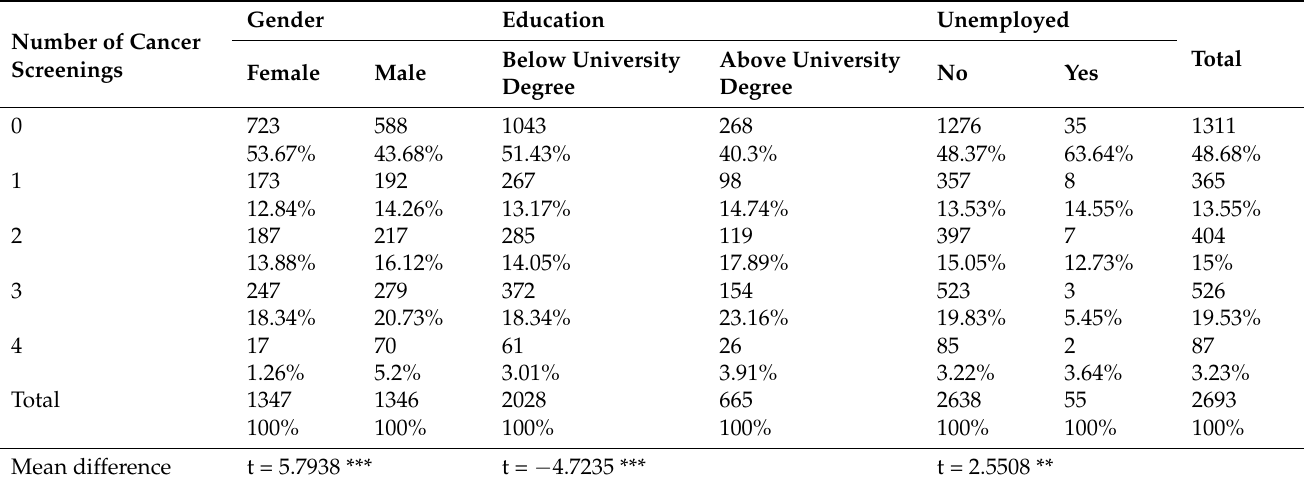
Table 4. Distribution of the number of cancer screenings by demographic characteristics.